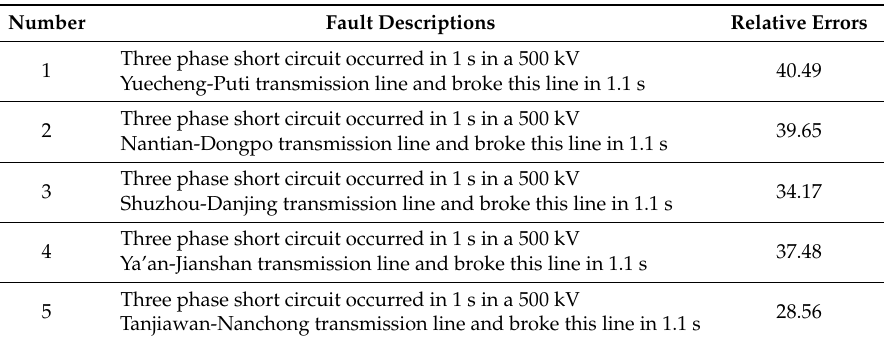
Table 5. Parameters of equivalent model (p.u).